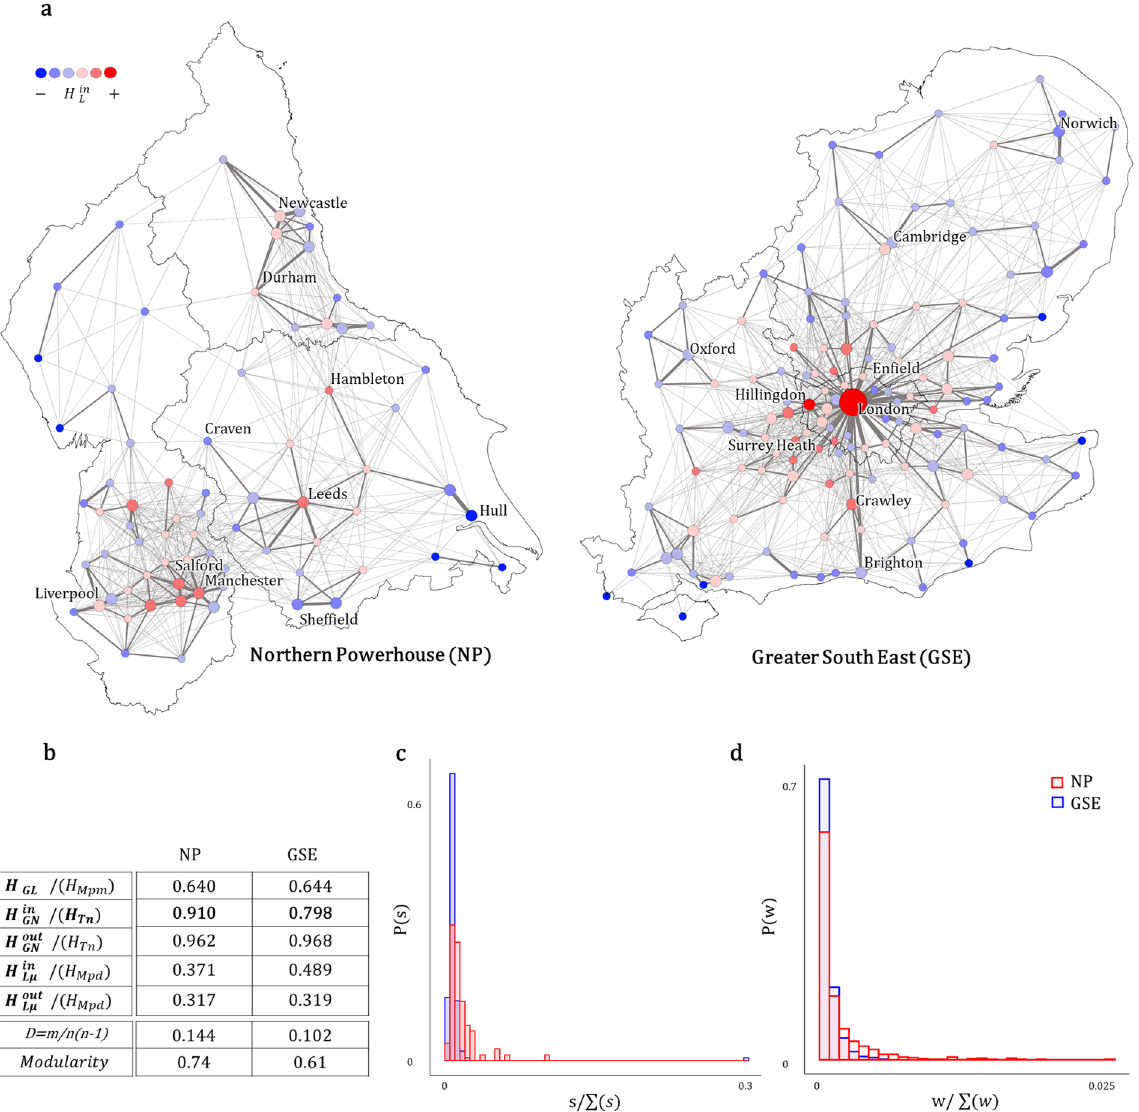
Figure 6. Northern Powerhouse (NP) and Greater South East (GSE) regions commuting patterns. ( a ) GSE and NP commuting networks with nodes corresponding to Local Authority District (LAD) levels. Values of / H Mpd are indicated in the colour scale of nodes, going from the lowest values in blue to the highest in red. H in L The size of nodes reflects the total count of in-commuting flows (in-strength s ). The width of links denotes the flow weight. ( b ) Outputs for normalised entropy measures for both systems, including link density ( D ) and modularity. ( c ) Normalised node in-strength distribution P ( s ) and ( d ) normalised link weight distribution P ( w ). (Map created by the authors with QGIS 2.18.15 software. URL www. qgis.